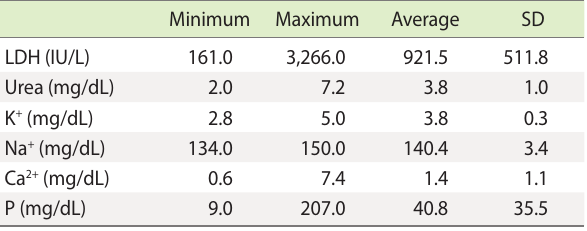
Table 3. Average laboratory variables in patients with